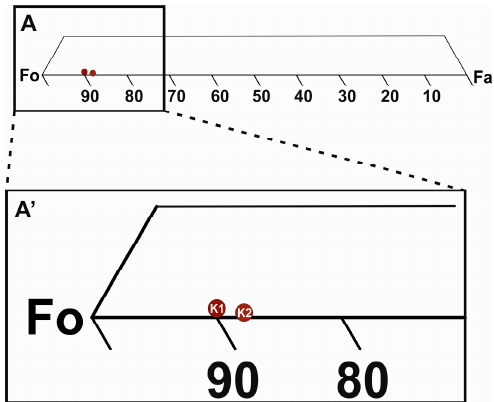
Figure 17. Classification diagram of identified olivine’s in samples collected from the Northern Portuguese continental shelf. The capital letters inside to each dot indicates the location of the sample on the map of Figure 10. Each number next to each capital letter is the reference of the analyzed mineral grain. In A’, it is possible to observe that the Fo end-member has a value greater than 85%. For the samples collected from the Porto canyon area the strong presence of the Fo end-member is also found (Figure 18A,A’).